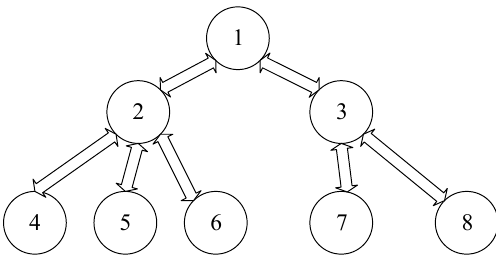
Figure 6. Diagram of the tree structure of the Type A network (without